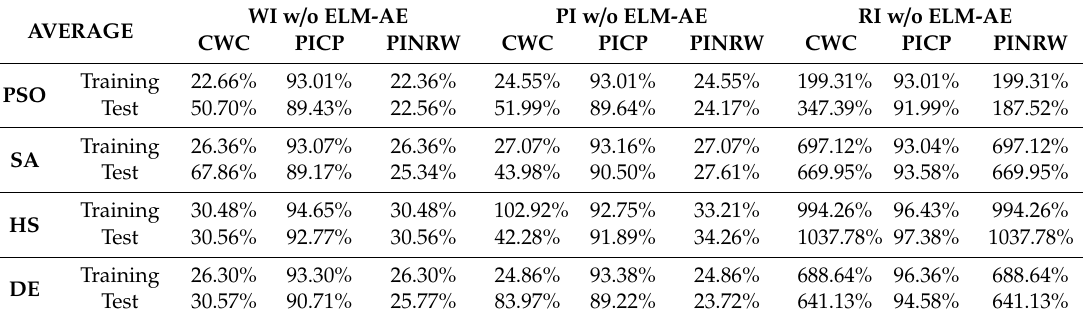
Table 4. Comparison of average results of di ff erent cases without ELM-AE.